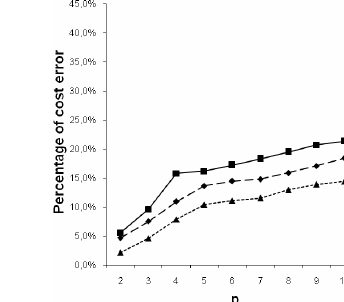
Figure 8. Cost error for 30 aggregated nodes. A C